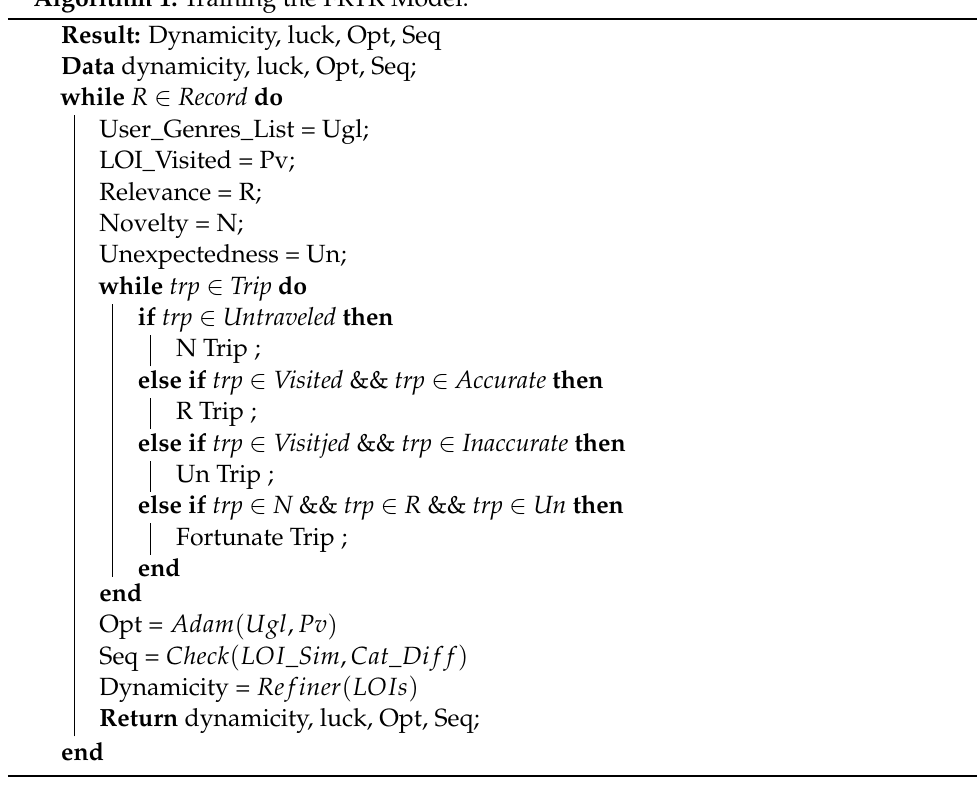
Algorithm 1: Training the FRTR Model.